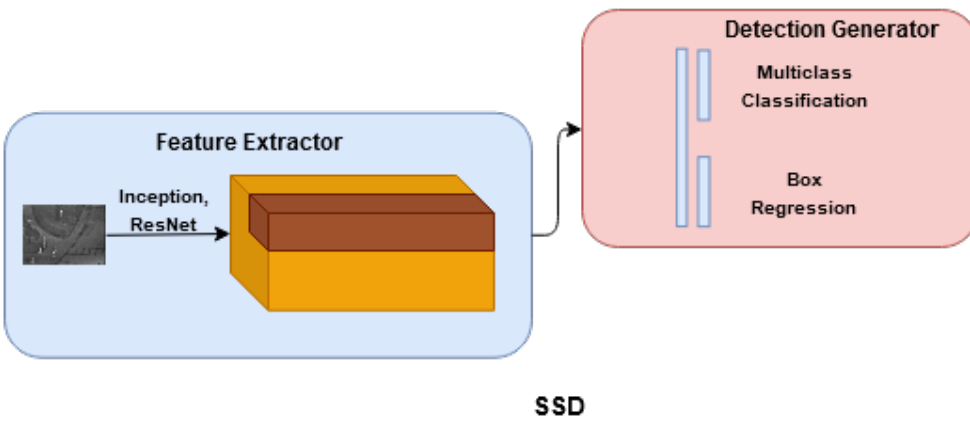
Figure 4. SSD approach for object